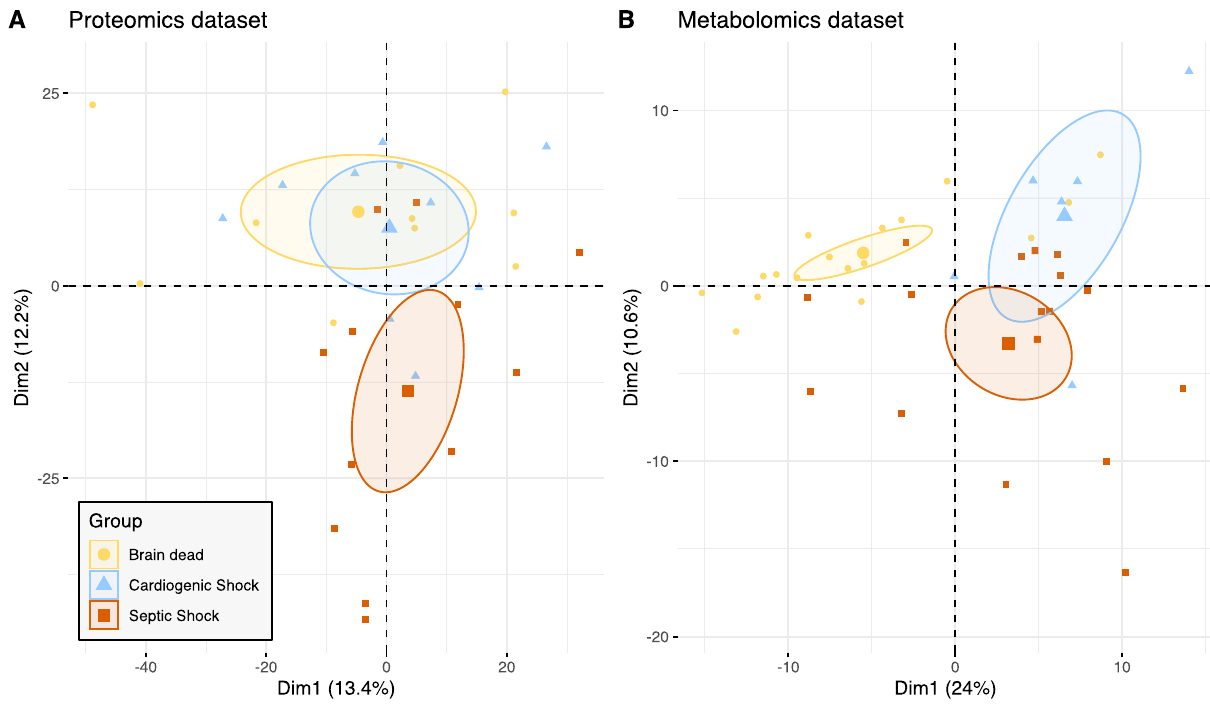
Figure 2. Principal component analyses of proteomic and metabolomic datasets. The two first dimensions are shown, defining the subspace maximizing the variance of the dataset. Every point represents an individual muscle proteome ( A ) or metabolome ( B ). The individuals are color-coded according to their group. Points that are close together tend to have similar proteome/metabolome. Large points and ellipses represent respectively the barycenter of each group and its 95% confidence interval. Dim indicates Dimension. Some samples were discarded due to quality checks. N = 31 patients analyzed for the proteomics (Septic shock n = 12, cardiogenic shock n = 9, brain dead n = 10) and N = 40 for the metabolomics (Septic shock n = 17, cardiogenic shock n = 6, brain dead n =